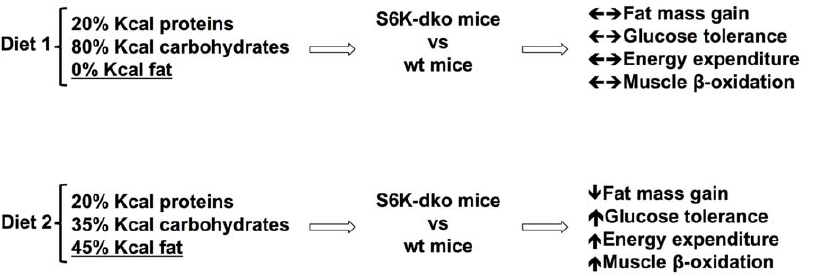
Figure 9. Model of metabolism regulation by diet in absence of S6K. Mice S6K-dko show lower fat mass gain and higher glucose tolerance, energy expenditure and muscle lipid b -oxidation compared with wt mice when consuming a high fat diet. Those metabolic differences are not present in absence of dietary lipids.